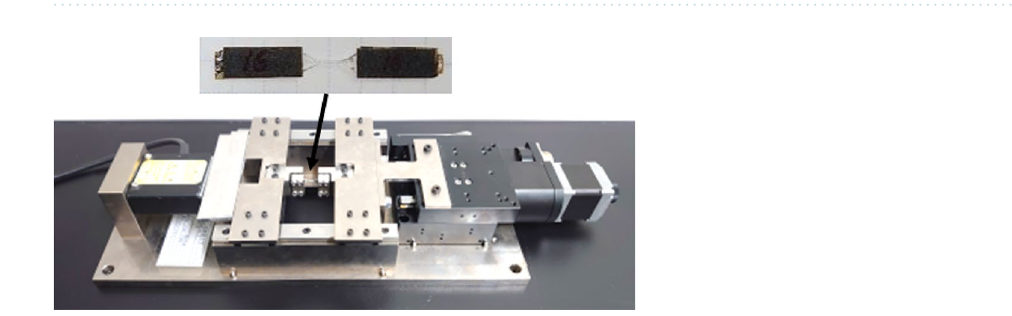
Figure 6. Tabletop tensile testing machine for the in-situ observation of the sample under an optical